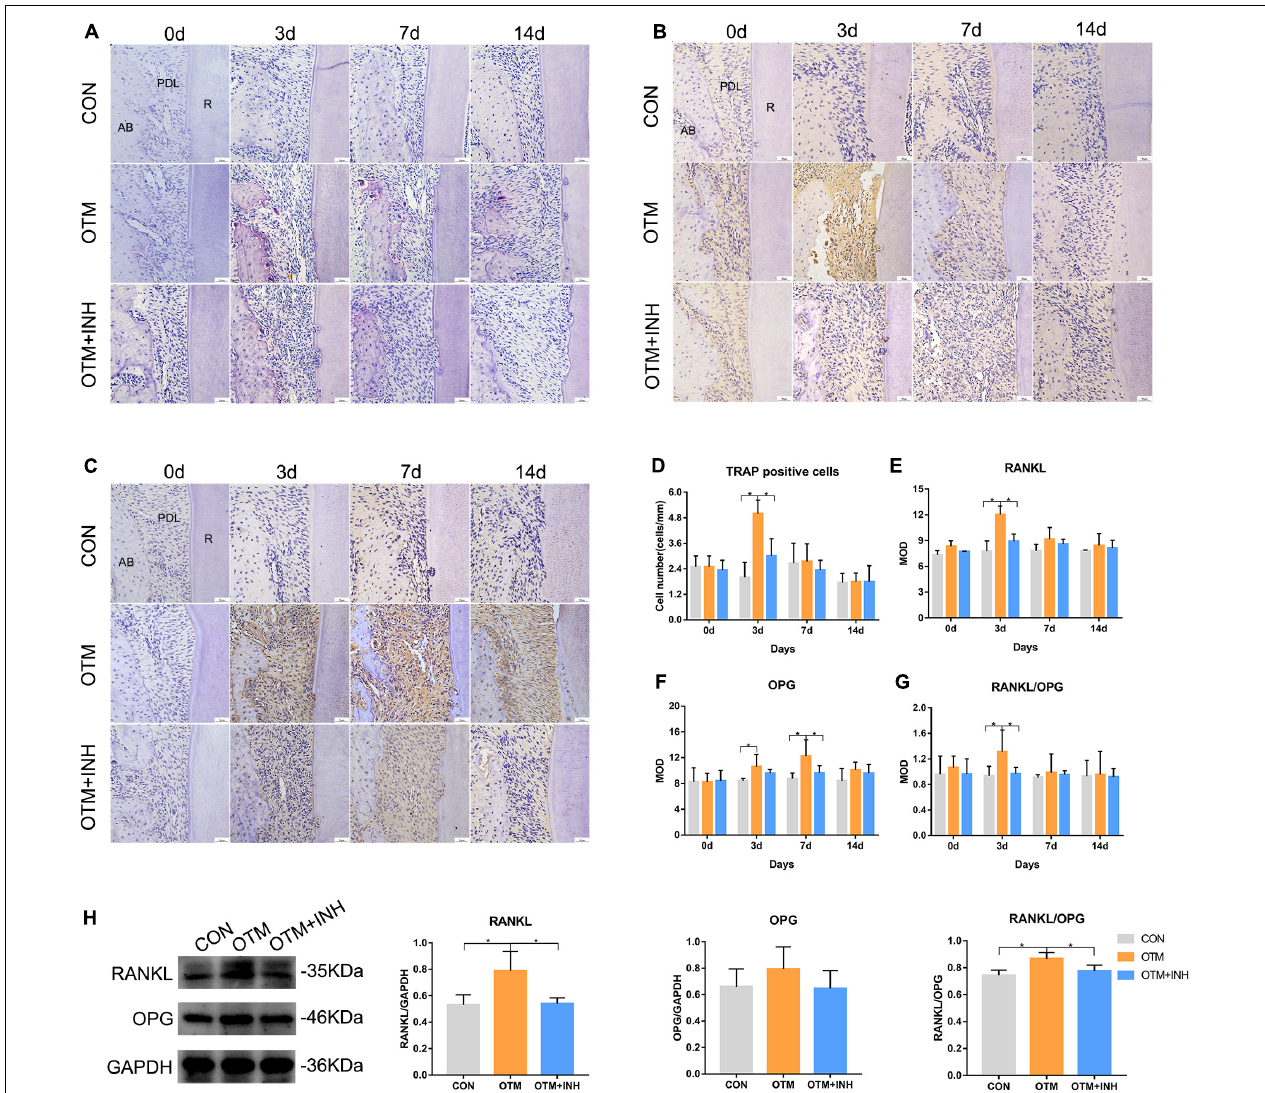
FIGURE 5 | Inhibition of Piezo1 suppressed osteoclastic activities on the tension side. TRAP staining (A) and quantification of TRAP-positive cells (D) . TRAP-positive osteoclasts were detected near the tension side of the roots. On day 3, the number of osteoclasts in the OTM group was significantly greater than that of the CON and the OTM + INH groups. Scale bar = 50 µ m. Immunohistochemical staining of RANKL (B) and OPG (C) of PDL on the tension side of the distobuccal roots. The means of the integrated optical density (IOD) of RANKL (E) , OPG (F) , and RANKL/OPG ratio (G) were shown. On day 3, the RANKL/OPG ratio of the OTM group was significantly greater than that of the CON and OTM + INH groups. Western blot analyses (H) were carried out to detect the protein levels of RANKL and OPG on day 3 of OTM. The protein expression of the RANKL/OPG ratio increased significantly in the OTM group and was reduced by GsMTx4 in the OTM + INH group. Data are presented as the mean ± SD. * p < 0.05. Scale bar = 50 µ m. TRAP, tartrate-resistant acid phosphatase; RANKL, receptor activator of nuclear factor-kappa B ligand; OPG, osteoprotegerin; AB, alveolar bone; R: